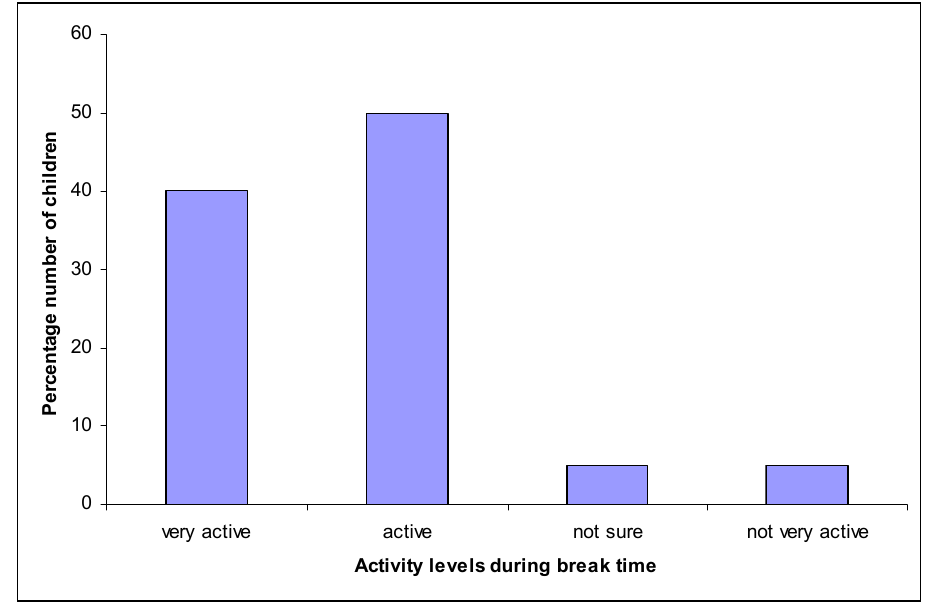
Figure 2. Children’s perception of how active they are during recess (break time).